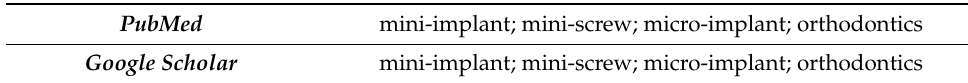
Table 1. Literature search